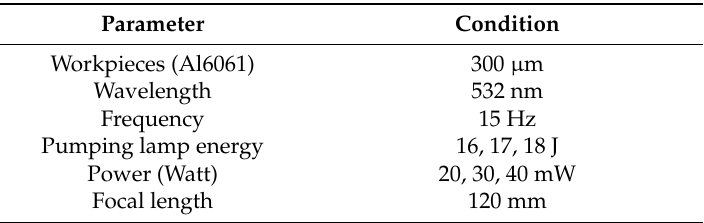
Table 3. Experimental parameters of laser drilling.